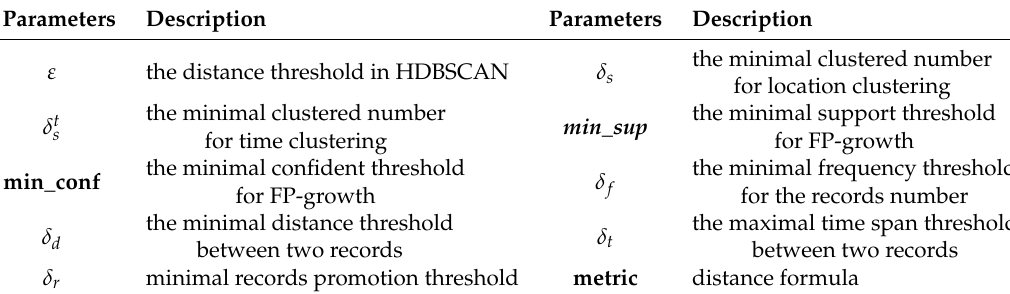
Table 3. Description of Parameter